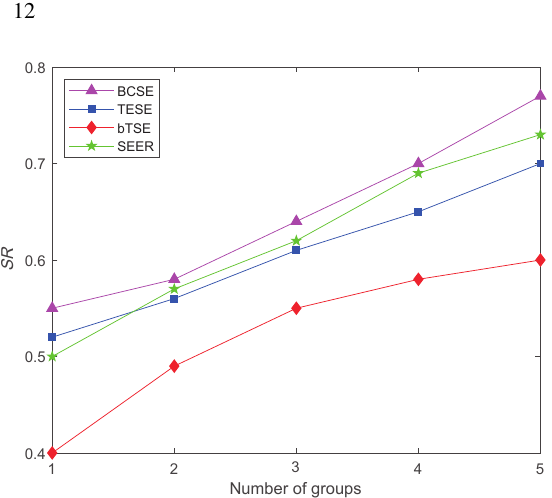
Fig. 9 Comparison of SR between the BCSE model and other models.